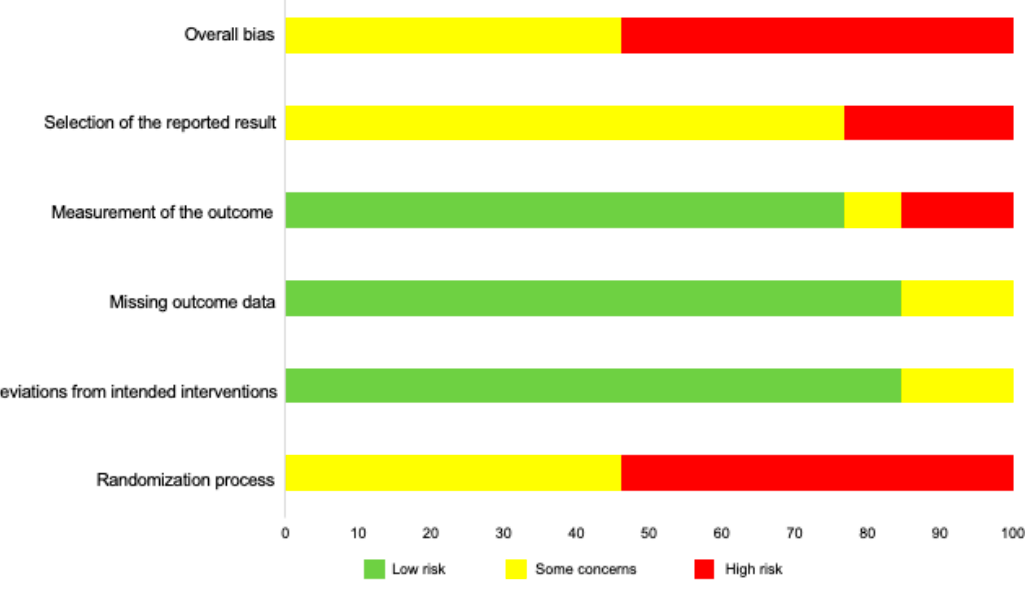
Figure 4. Risk of bias across studies focusing on the brain, in both mice and humans. This figure displays the relative percentages of intention-to-treat data of assessed risk of bias in the brain in human and mouse studies. The overall bias was determined using five categories: Selection of the reported result, measurement of the reported outcome, missing outcome data, deviations from intended interventions, and randomization process. Risk was determined as “low risk,” “some concerns,” or “high risk,” based on the Cochrane RoB 2.0 tool algorithm. The data for this figure included 14 articles. Table 2. IL-33 action in the